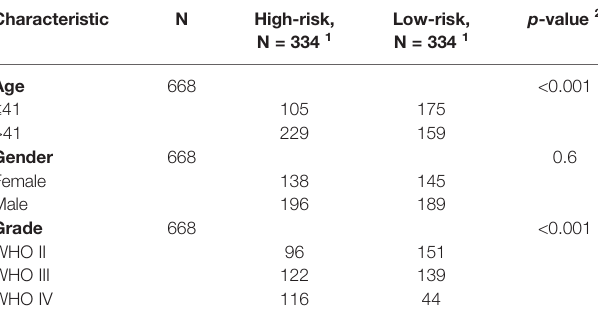
TABLE 3 | Characteristics of patients in low and high-risk scores in TCGA cohort.